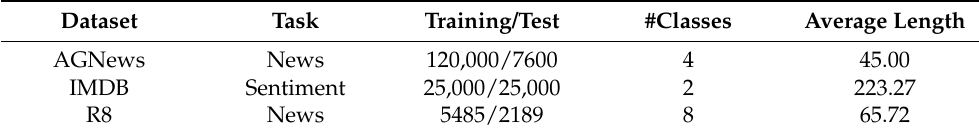
Table 1. Statistics of